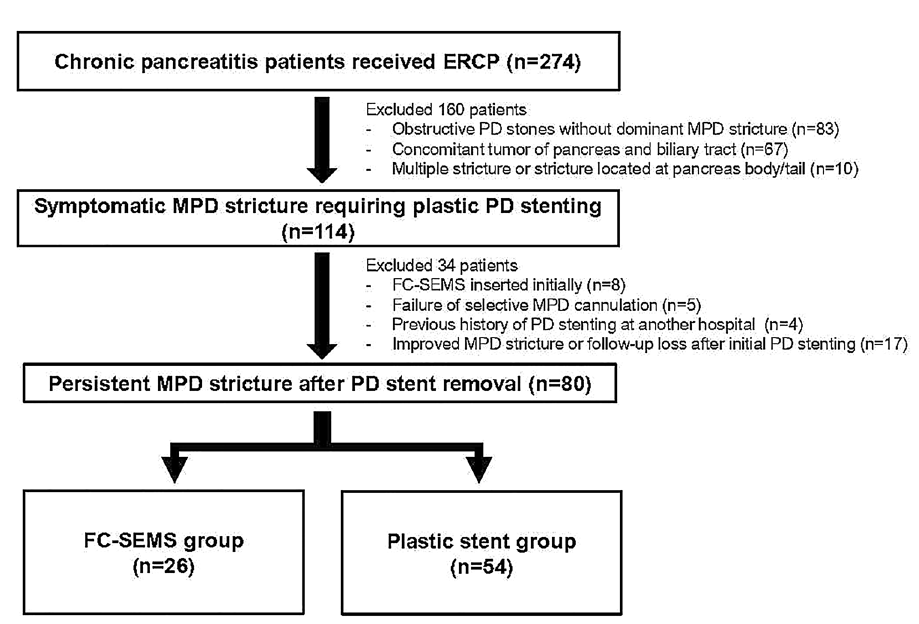
Figure 4. Flowchart for the study population. Abbreviation: ERCP, endoscopic retrograde cholangiopancreatography; FC-SEMS, fully covered self-expandable metal stent; MPD, main pancreatic duct; PD, pancreatic